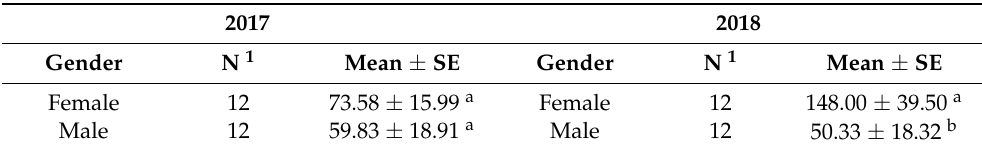
Table 2. Average numbers of adult males and females caught on blueberries using Suzukii ® bait traps during the sampling periods in 2017 and